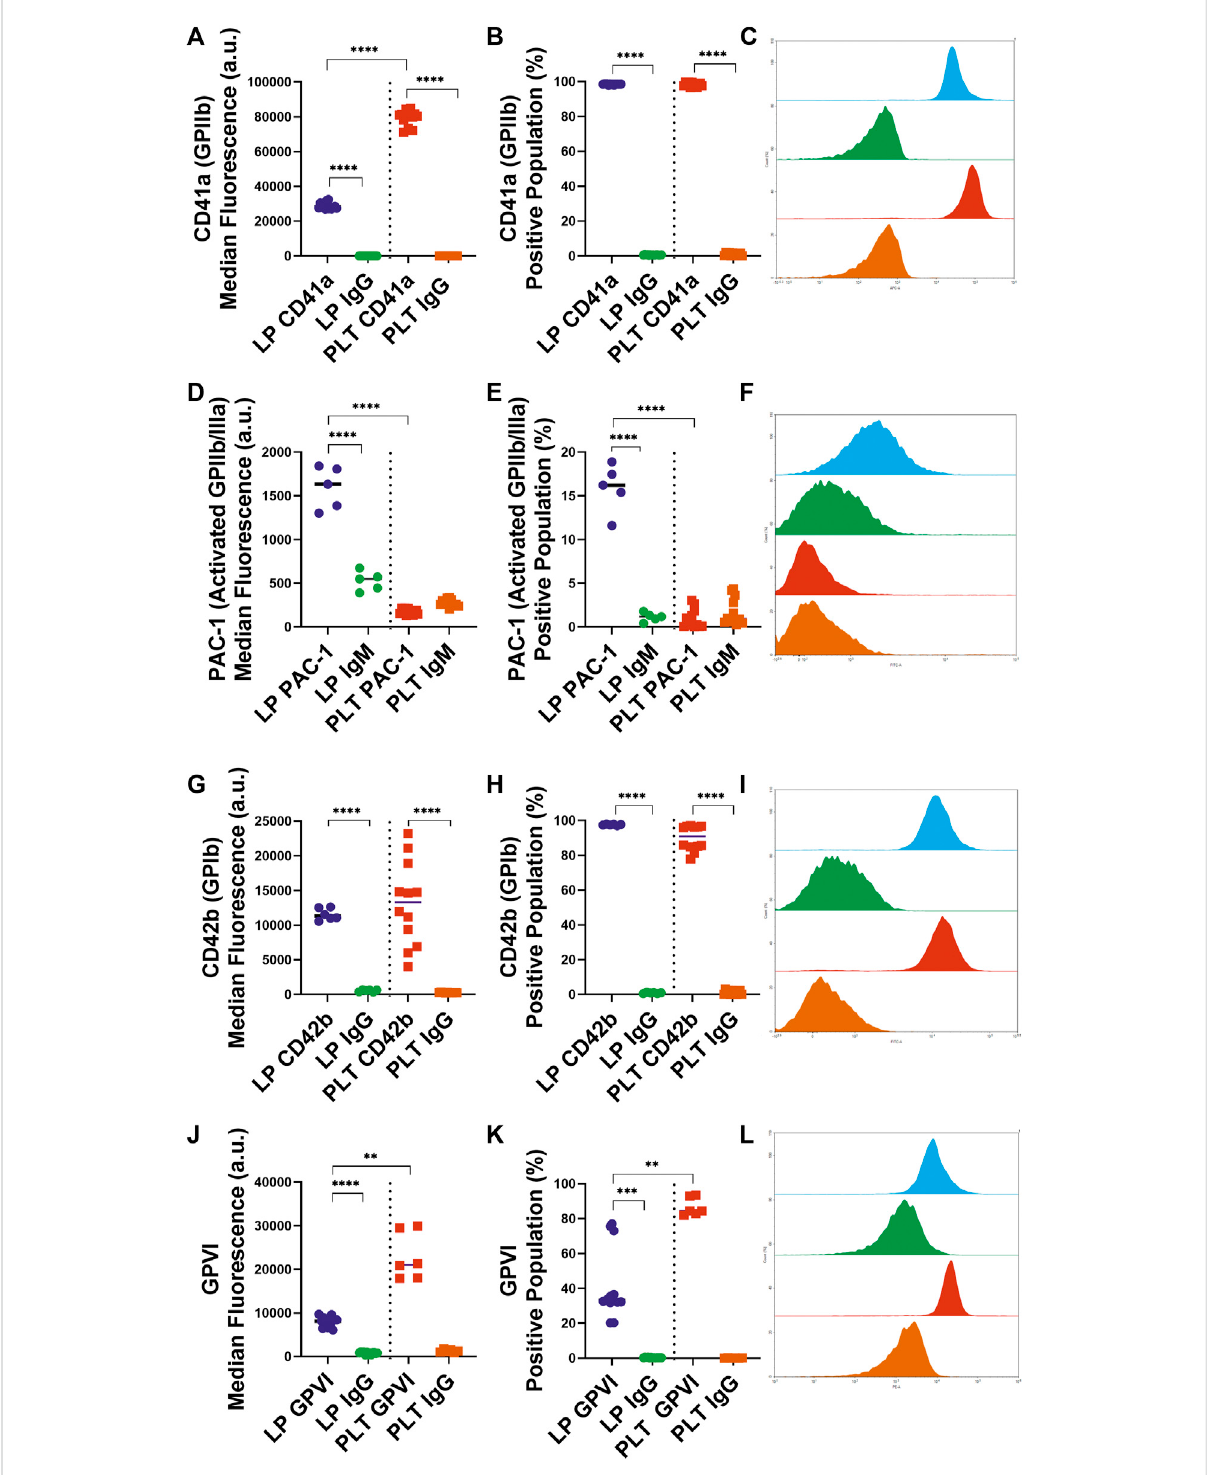
FIGURE 1 Characterization of Key Receptor Surface Expression on Lyophilized and Fresh Human Platelets by Flow Cytometry. Quanti fi cation of expression level (left), percent positive events (middle), and representative histograms (right), for (A,B,C) GPIIb [LP: n = 14, PLT: donors = 5, n = 12], (D,E,F) active GPIIb/IIIa [LP: n = 6, PLT: donors = 4, n = 12], (G,H,I) GPIb [LP: n = 6, PLT: donors = 5, n = 12], (J,K,L) GPVI [LP: n = 13, PLT: donors = 3, n =